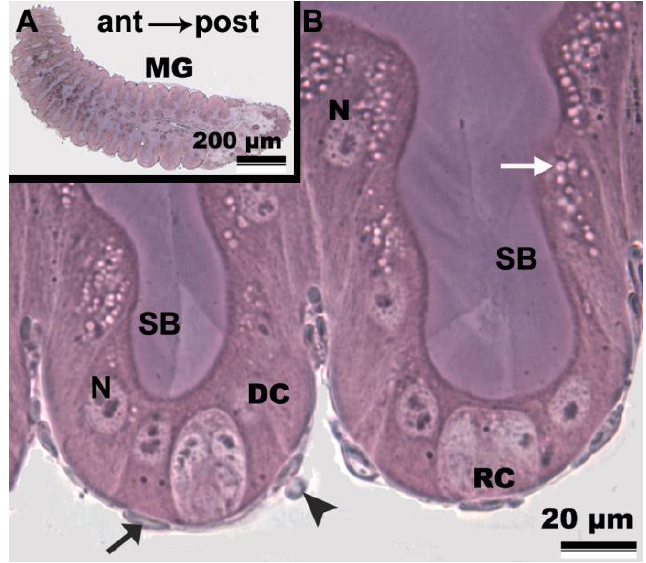
Figure 1. Light micrographs of the midgut of Friesella schrottkyi worker . ( A ) Overview of the midgut (MG). Arrow—antero-posterior orientation. ( B ) Epithelium showing columnar digestive cells (DC) with well-developed nuclei (N), apical striated borders (SB) and cytoplasm vacuoles (white arrow). Note regenerative cells nests (RC). Black arrow—nucleus of circular muscle. Arrowhead—nucleus of longitudinal muscle.